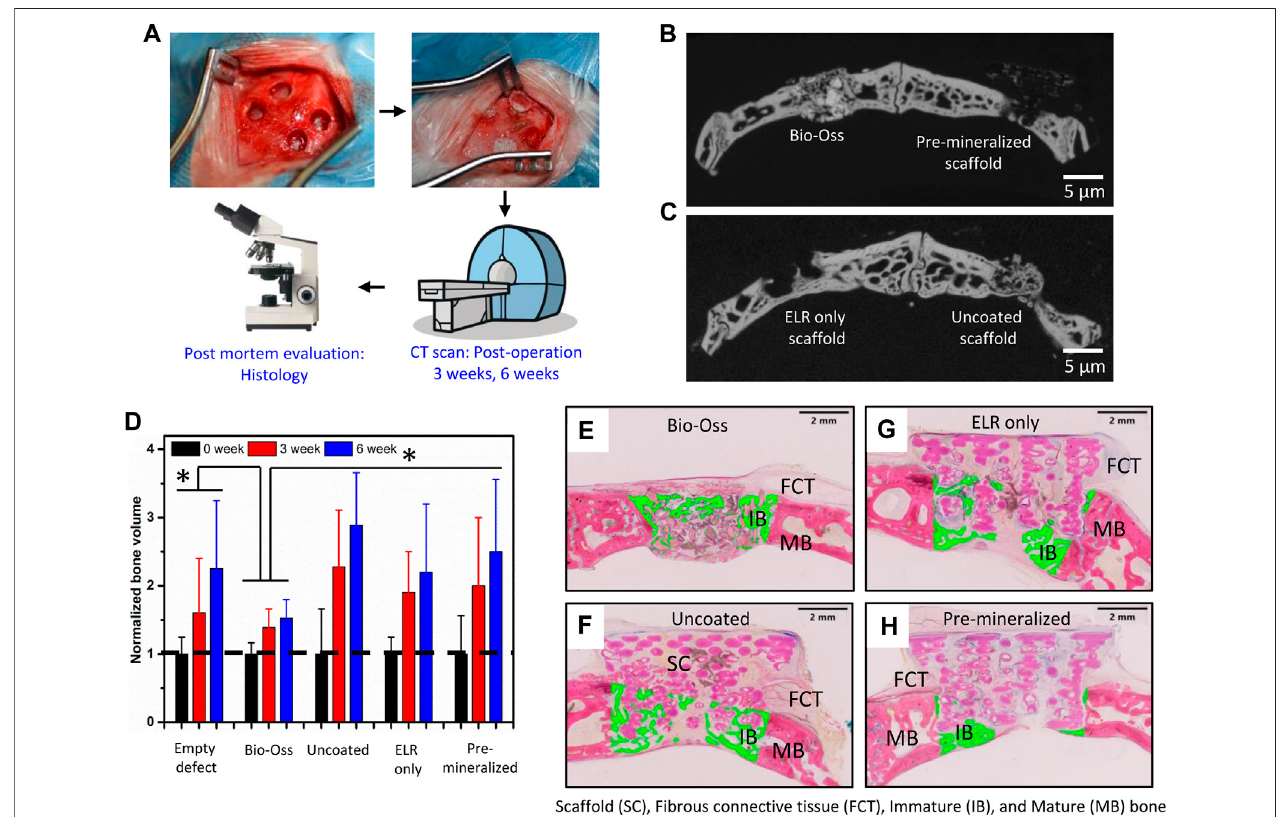
FIGURE 3 | In vivo characterization. (A) Schematic of the study plan and view of the rabbit calvarial bone defect before and after implantation. Micro CT images of new bone formationin [ (B) ,left] the positivecontrol (Bio-Oss) and [ (B) ,right] “ Pre-mineralized ” scaffold and [ (C) ,left] “ ELR only ” and [ (C) ,right] “ Uncoated ” scaffolds. (D) Normalized volume of newly formed bone with different test samples after 0, 3, and 6 weeks of implantation. Histological sections stained with Giemsa-Eosin depicting new bone formation marked with green colour after 6 weeks of implantation including (E) positive control (Bio-Oss), (F) “ Uncoated ” nylon scaffold, (G) “ ELR only ” coated nylon scaffold, and (H) “ Pre-mineralized ” scaffold. Scaffold (SC), Fibrous connective tissue (FCT), Immature (IB) and Mature (MB) bone. In (D) * represents signi fi cantdifference p < 0.05 innormalized bone volume betweensamplegroups and atdifferenttime points, estimated using two-way ANOVA inGraphPadPrism ver. 6